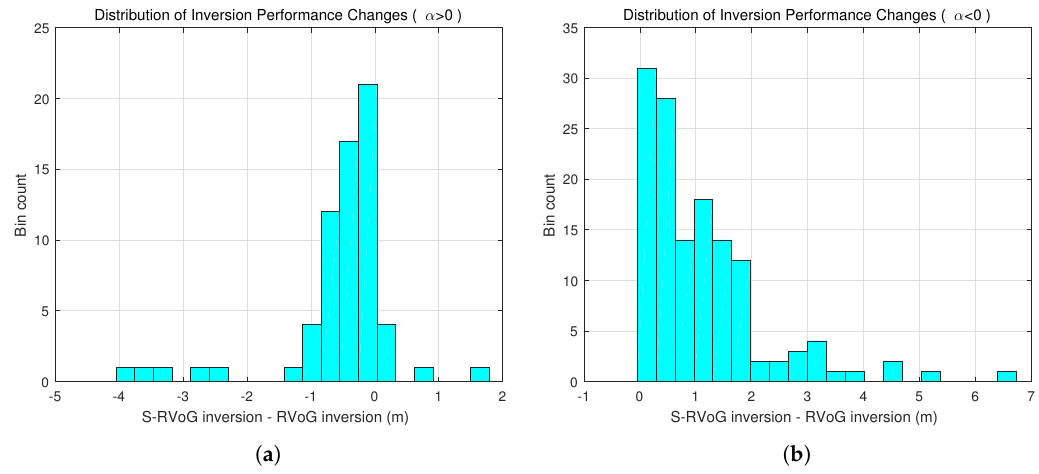
Figure 12. The distribution of inversion performance changes for α > 0 ( a ) and α < 0 ( b